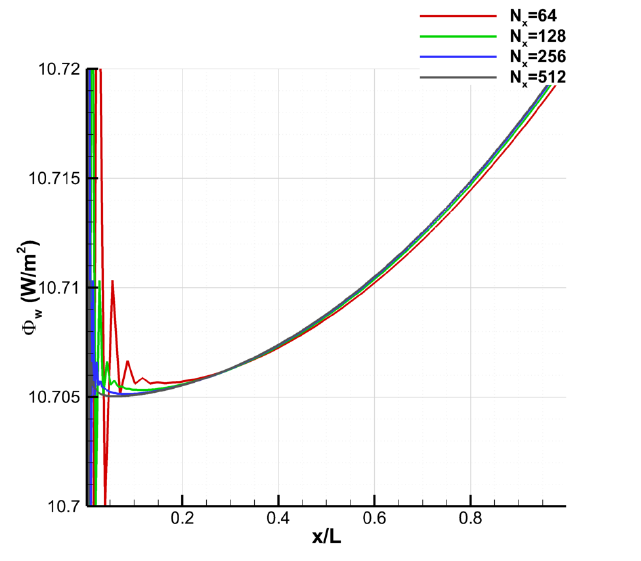
Figure 5. φ w for N x = 64 to N x = 512. Test case 1, N =